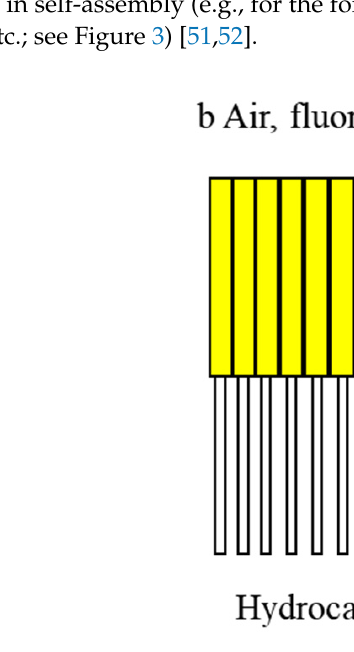
Figure 3. Fluorinated self-assembled films and colloids. ( a ) Monolayer of fluorosurfactant at the water/air (or water/fluorocarbon) interface; ( b ) illustrates the fact that F-alkyl and alkyl chains are mutually phobic: semifluorinated alkanes (CnF2n+1-CmH2m+1; SFA) organized as monolayers at hydrocarbon/air (or hydrocarbon/fluorocarbon) interface. Adapted from [6].